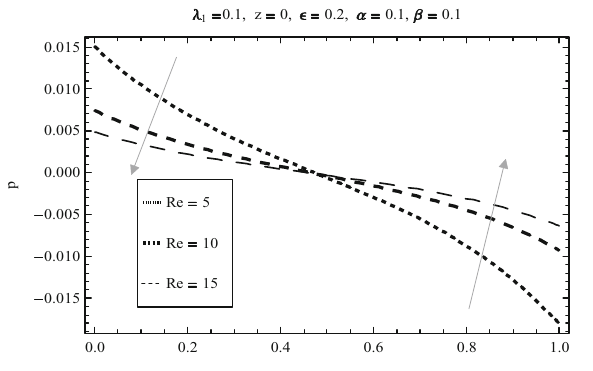
Fig. 17 Variation of p along y for different values of Re